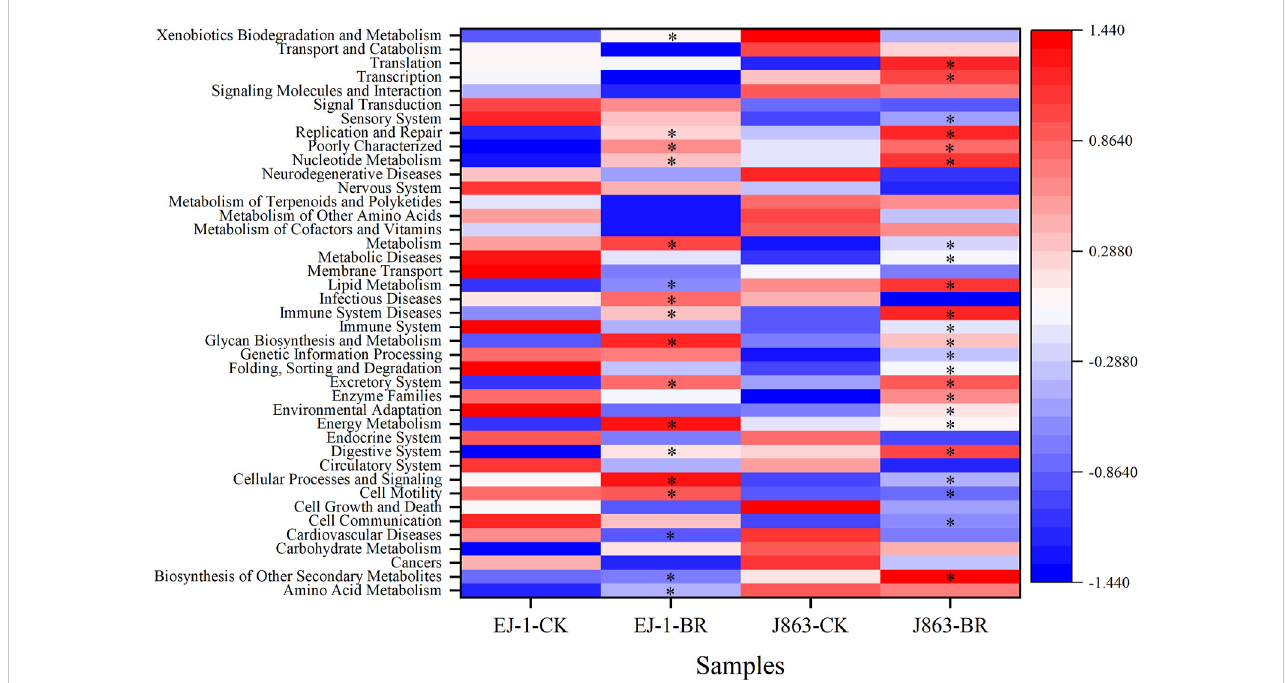
FIGURE 8 A heatmap of the predicted KEGG functional pro fi les (KEGG level 2) of bacterial microbiota across all samples. * represents functional pathways enrichment. CK represents treatment with blank control, BR represents treatment with broccoli residues. EJ-1 represents susceptible cultivar for CVW, J863 represents resistant cultivar for CVW.